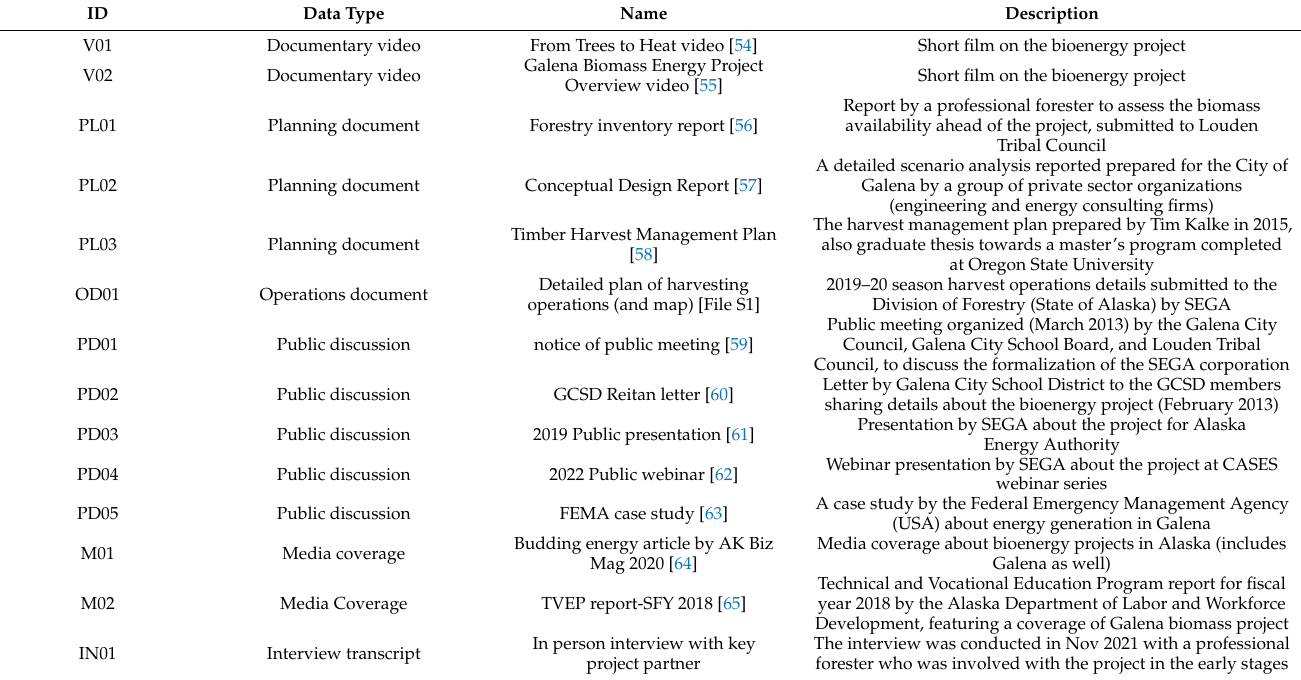
Table 1. The dataset used for thematic analysis for this study.